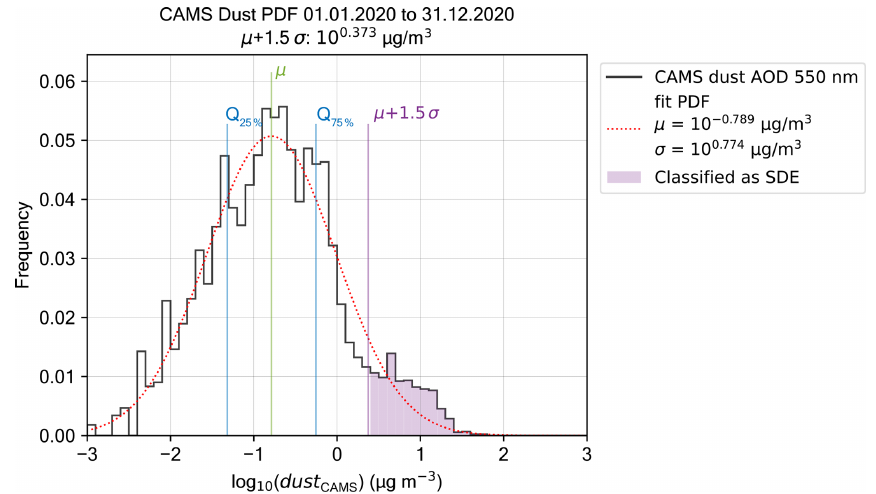
Figure 2. Frequency distribution of dust CAMS concentrations at JFJ with fitted lognormal curve, the corresponding mean, 25th and 75th percentiles (Q 25% and Q 75% ), and the threshold for an SDE signal of dust CAMS ≥ µ + 1 . 5 σ = 2 . 36µgm − 3 , indicated in purple